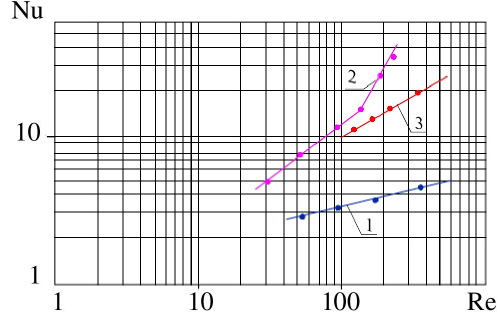
Figure 8. The effect of gas flow velocity on the interphase heat transfer intensity: 1 —“gravitation- ally falling layer” mode; 2 —“weighted layer” mode; 3 —the fluidized bed on a horizontal grid.